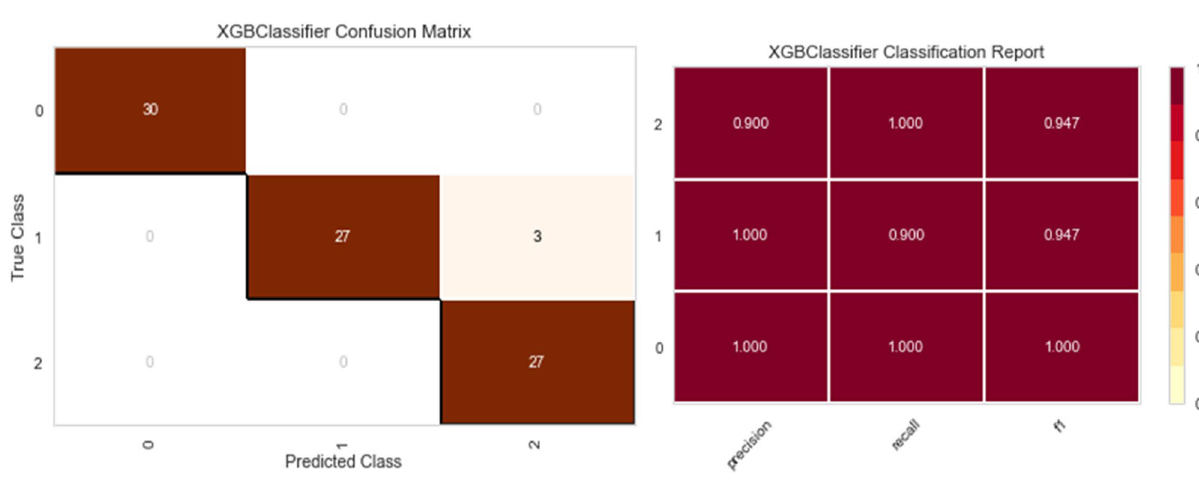
Figure 9. Matrix confusion and Report Classification of XGB